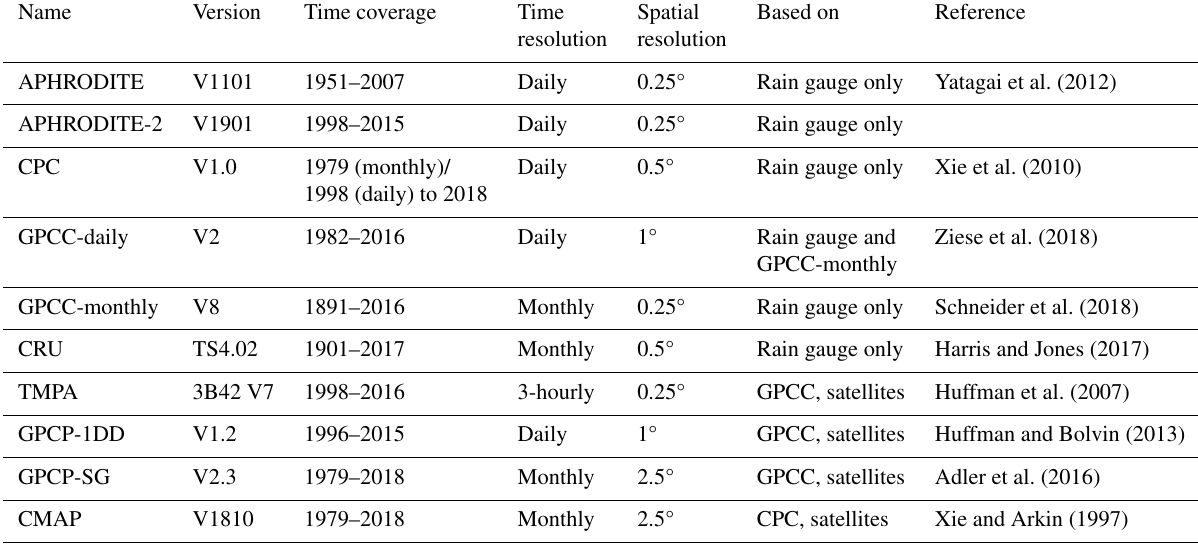
Table 1. Observational datasets of precipitation selected for this study, derived from rain gauges or satellites.